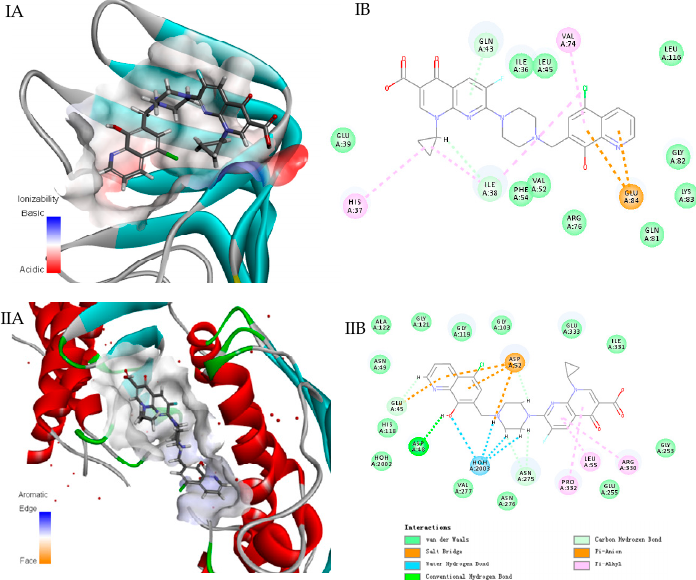
Figure 2. Interactions of compound 5d in the active site of the LptA and DNA Top IV (Docking with Discovery Studio). (I A/B) LptA; (II A/B) Top IV. Compound is shown as stick models with green carbon atoms, blue nitrogen atoms, red oxygen atoms, and yellow sulfur atoms. Hydrogen bonds are depicted as red dashes in three-dimensional view and green dashes in two-dimensional view. Salt bridge interactions are depicted as brown dashes; pi-sulfur interactions are depicted as yellow dashes; pi-alkyl interactions are depicted as purple dashes.